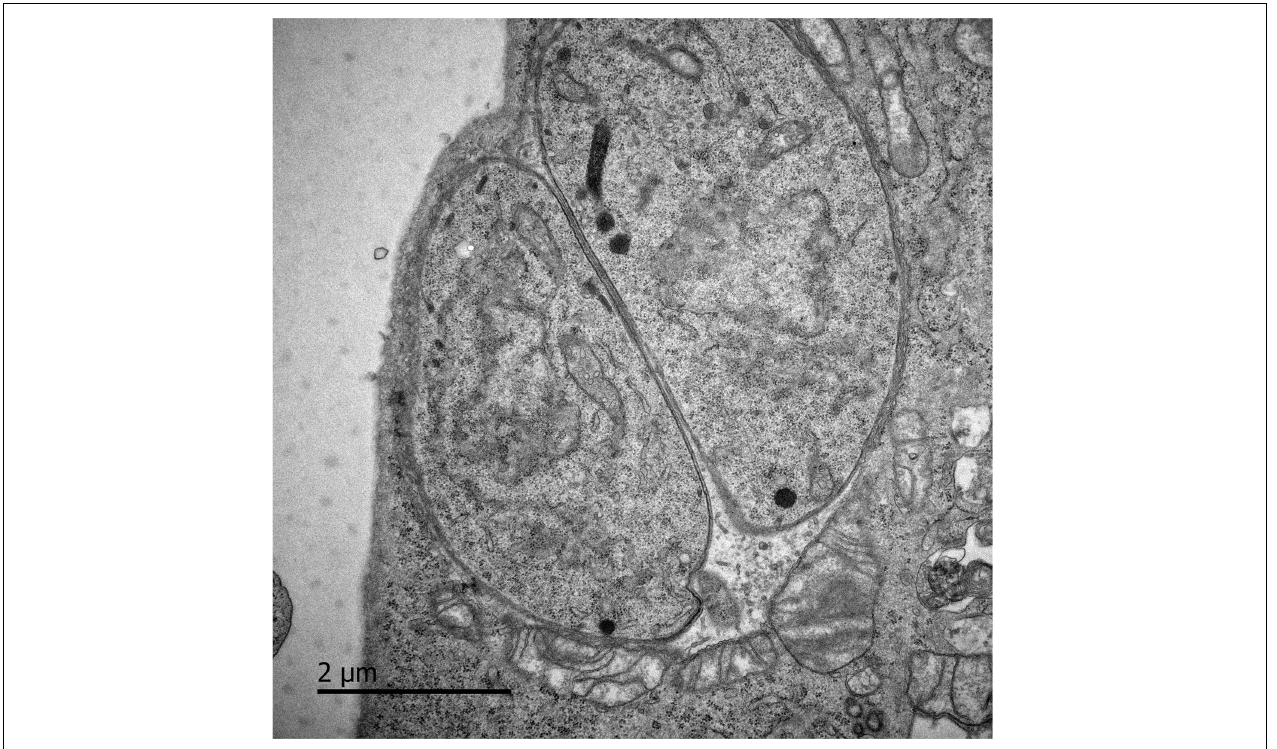
FIGURE 3 | Murine embryonic fibroblasts, 6 h after infection with Toxoplasma gondii tachyzoites. Persistent pathogens such as Toxoplasma may reactivate during acute COVID-19. Original image courtesy of Dr. Lena Pernas.